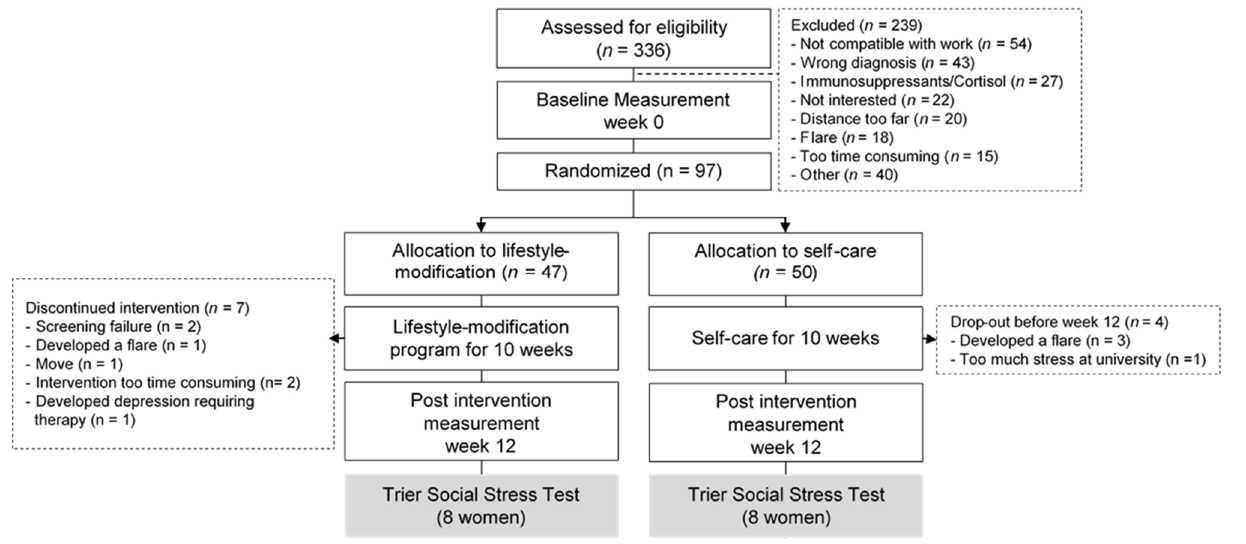
Figure 1. Study Figure 1. Study flow-chart.